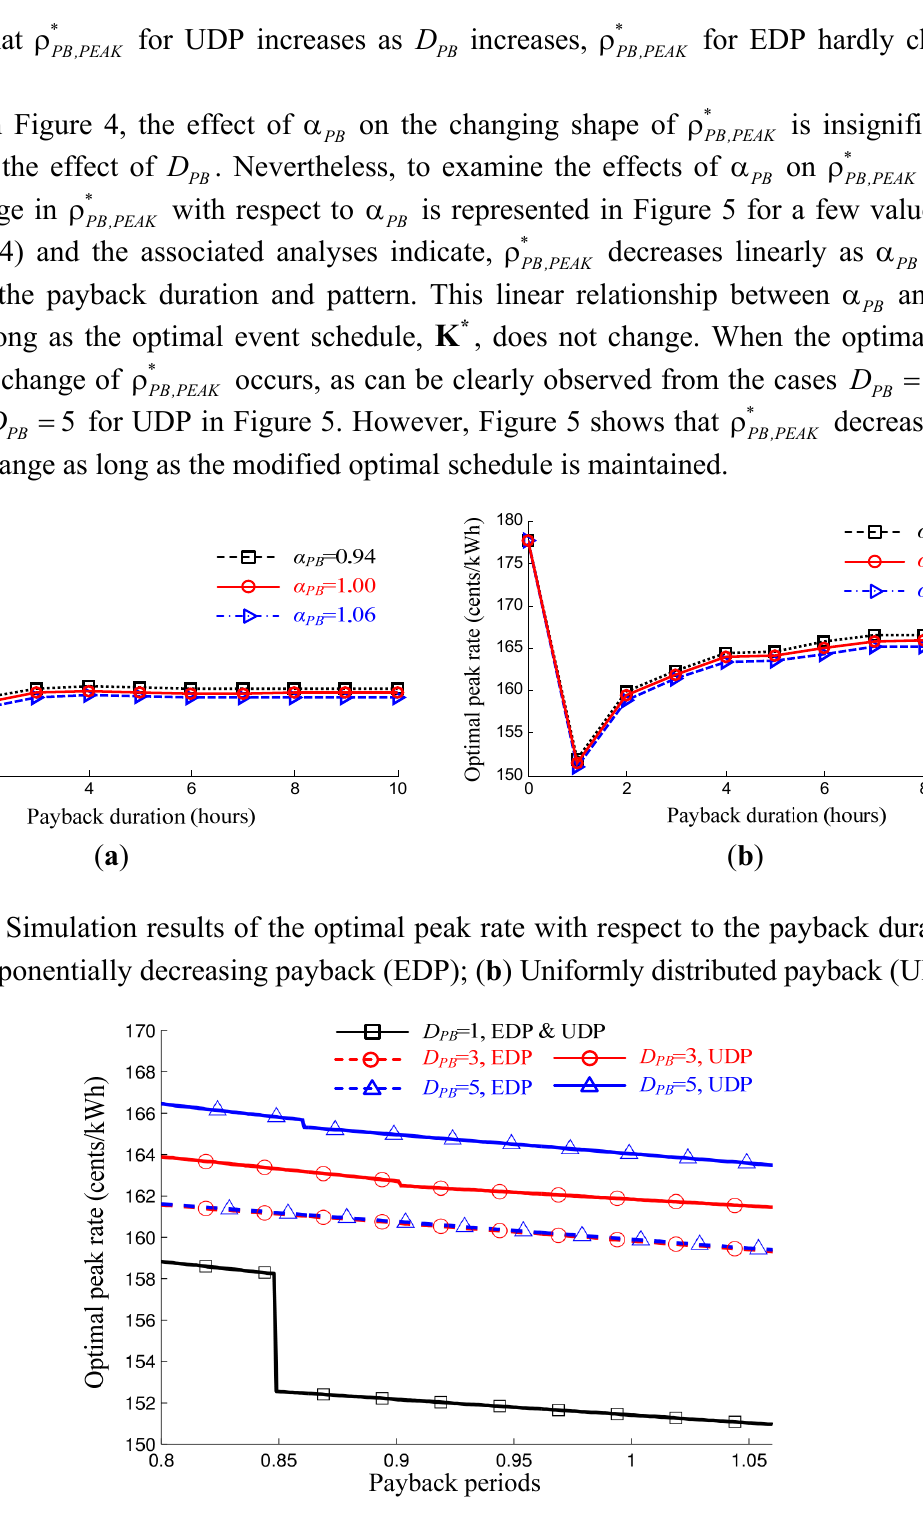
Figure 5. Simulation results of the optimal peak rate with respect to the payback ratio for selected values of D PB